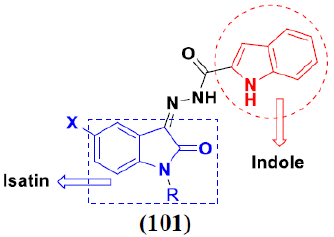
Figure 96. Structure of isatin ‐ indole derivatives ( 101 ). Table 86. In vitro cytotoxic activities of isatin ‐ indole hybrid compounds 101 ( a – d ).